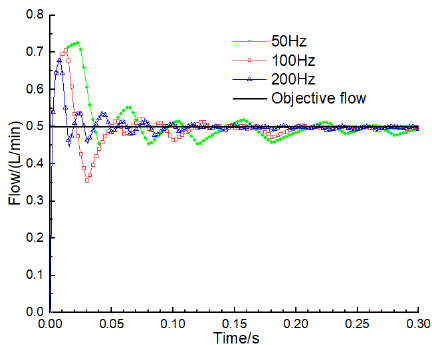
Figure 12. Flow response curve of single valve closed-loop control.